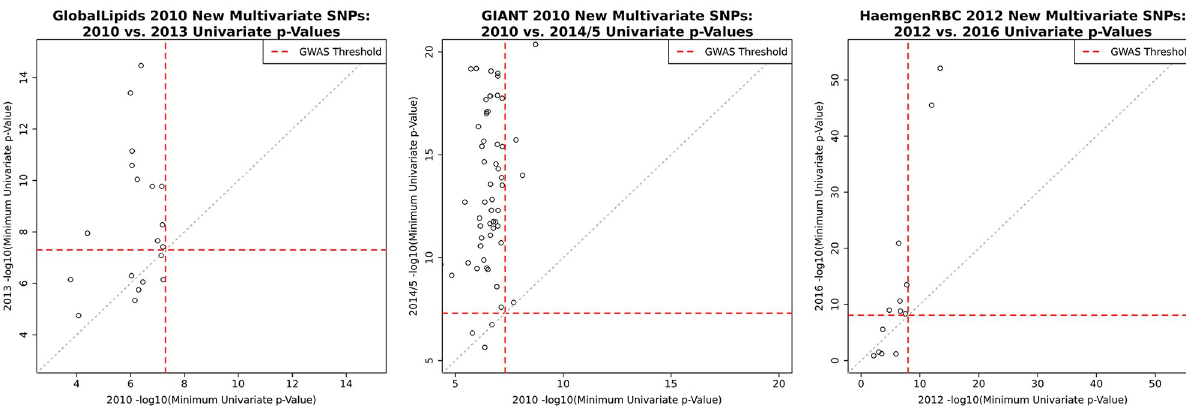
Fig 2. Replication of new multivariate associations. The figure shows results based on earlier and later releases from studies with multiple releases (GlobalLipids, GIANT, and HaemgenRBC). Each point represents a new multivariate association identified in our multivariate analysis of the earlier release. The x - and y -axes show the minimum (across phenotypes) of the -log 10 univariate p -values from the earlier release ( x -axis) vs. the later release ( y -axis). Dashed red lines represent the univariate significance GWAS thresholds used for each study’s releases. Across all three studies, 84 out of 94 new multivariate associations from the earlier releases have smaller minimum univariate p -values in the later release, and 68 out of 84 new multivariate associations that did not reach GWAS significance in the earlier release do so in the later release (see S5 Table for a per-dataset